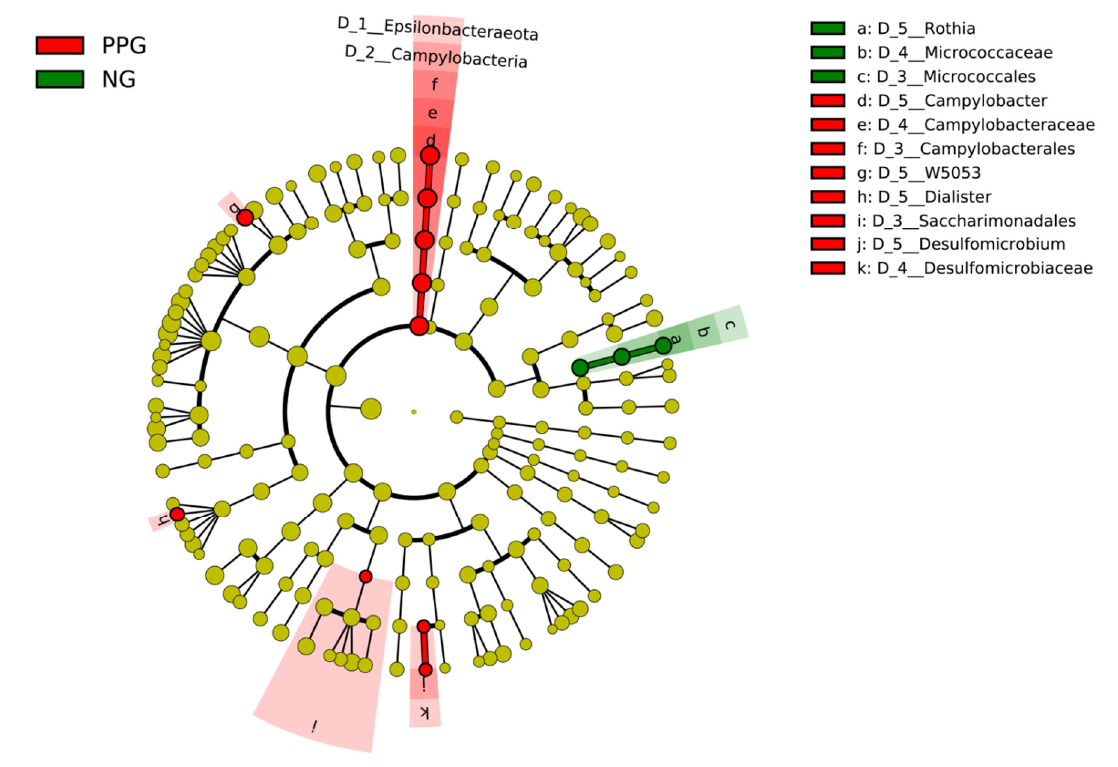
Figure 6. Cladogram from LEfSe analysis of saliva bacterial genera in PPG and NG groups classified by using both HbA1c and FPG levels. Green and red colors indicate the bacterial genera with higher abundance in PPG and NG, respectively.